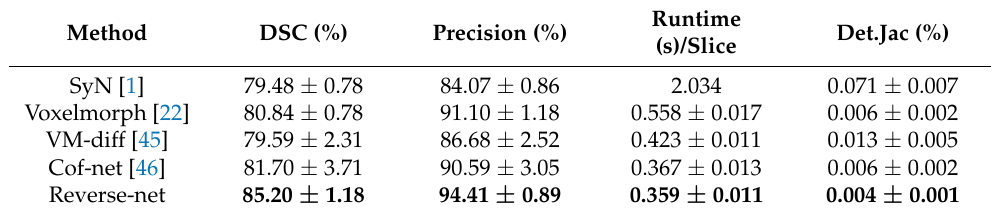
Table 2. Quantitative results on the MRbrain dataset. Bold indicates the highest score.